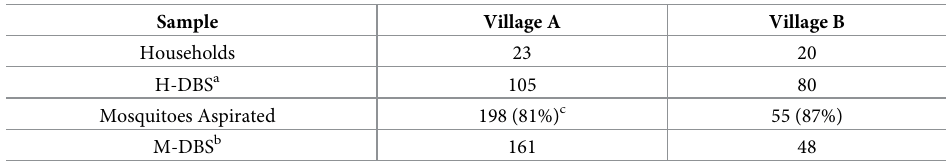
Table 1. Summary of enrollment and sampling